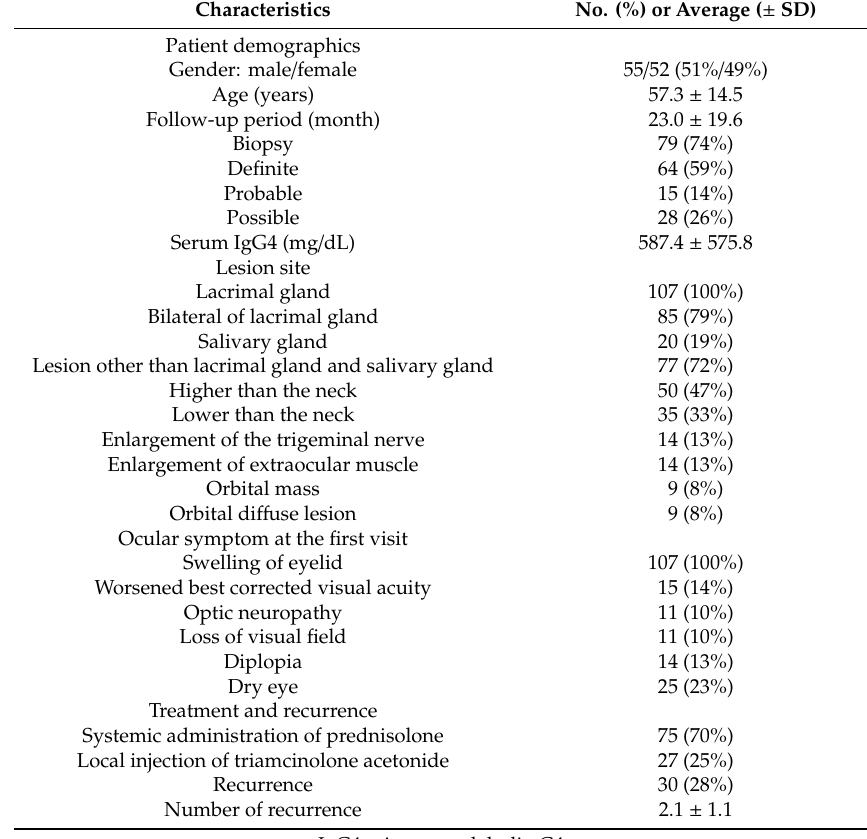
Table 1. Patients’ demographics, lesion site, ocular symptom, treatment, and recurrence.